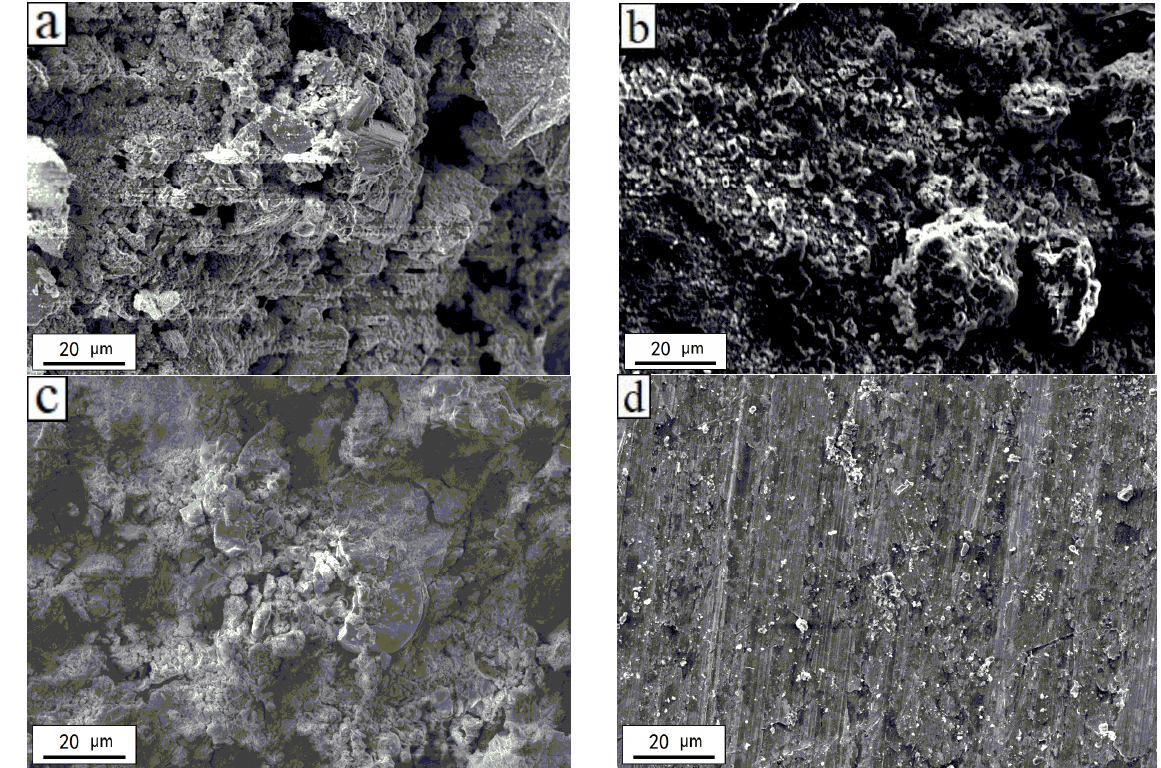
Figure 3. Microscopic morphology analysis of the hanging ring in ( a ) Position #1, ( b ) Position #4, ( c ) Position #8, and ( d ) Position #5. Table 3. EDS surface scanning analysis results for the hanging rings at different positions.